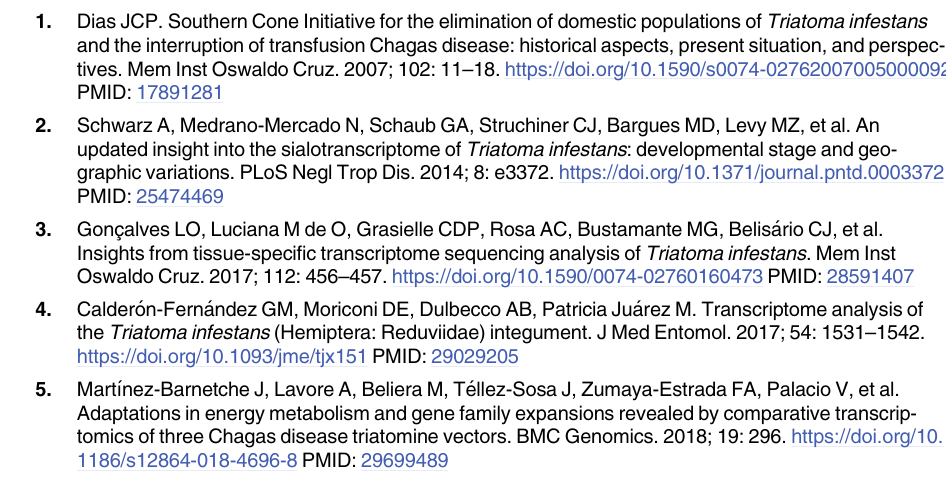
S3 Fig. Volcano plot showing the effect of deltamethrin treatment on transcript abundance in T . infestans . X-axis and y-axis represent log2 fold-change (FC) differences between the compared groups and statistical significance as the negative Log of P-values, respectively. The abundance of 9,887 transcripts (generated after the filtering step) was plotted. Transcripts with p-value (FDR) < 0.05 are indicated with red dots and non-significant transcripts are shown as black dots.